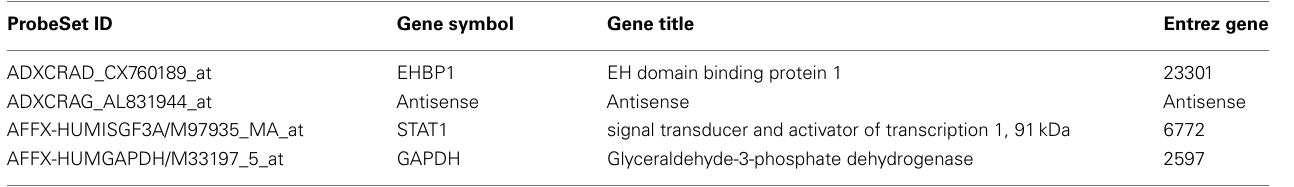
Table 2 | List of genes that is represented by the genetic signature